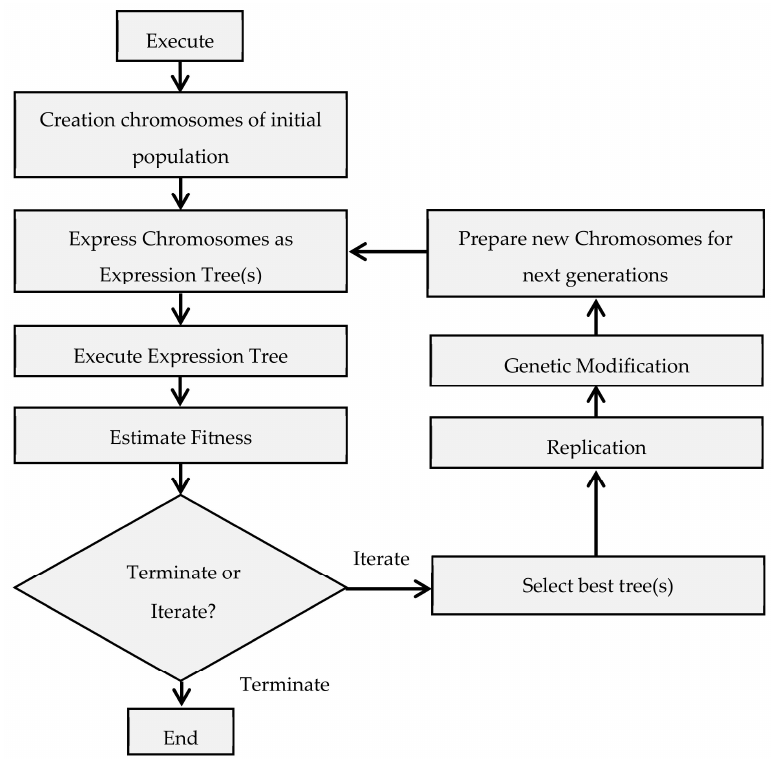
Figure 3. Flowchart for GEP model construct.